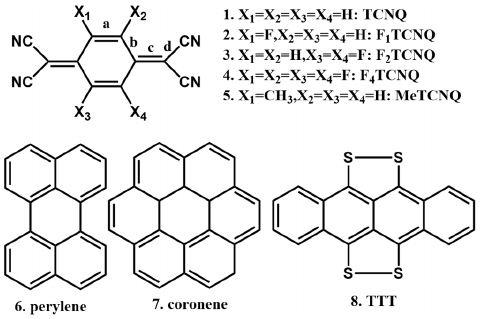
Figure 1. Molecular structures of organic donors and acceptors for the formation of charge-transfer cocrystals discussed in this review.